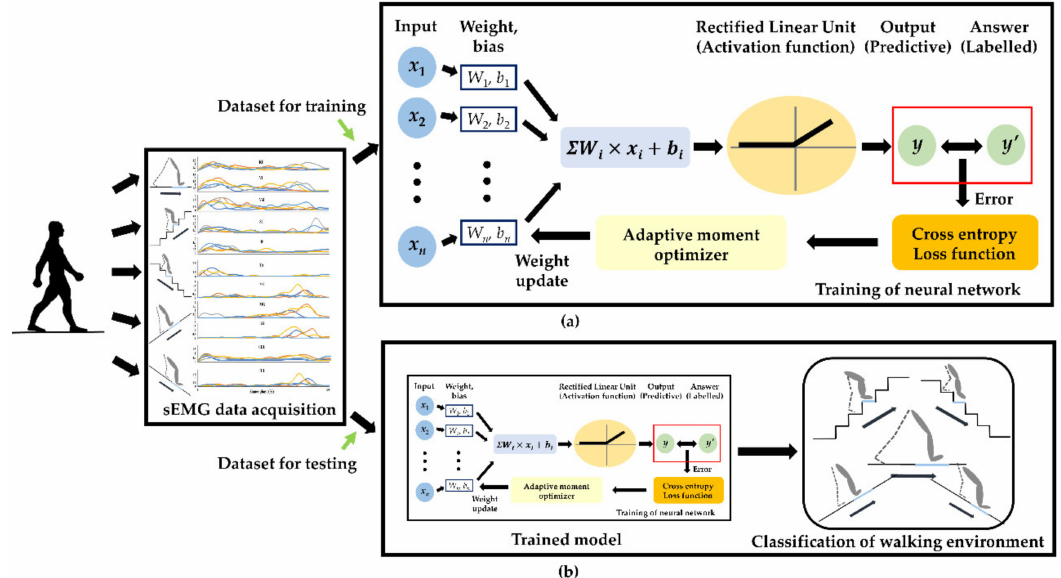
Figure 4. Schematics of the classification procedures using sEMG signals as the input to an artificial neural network ( a ) training the artificial neural network, ( b ) classification of walking